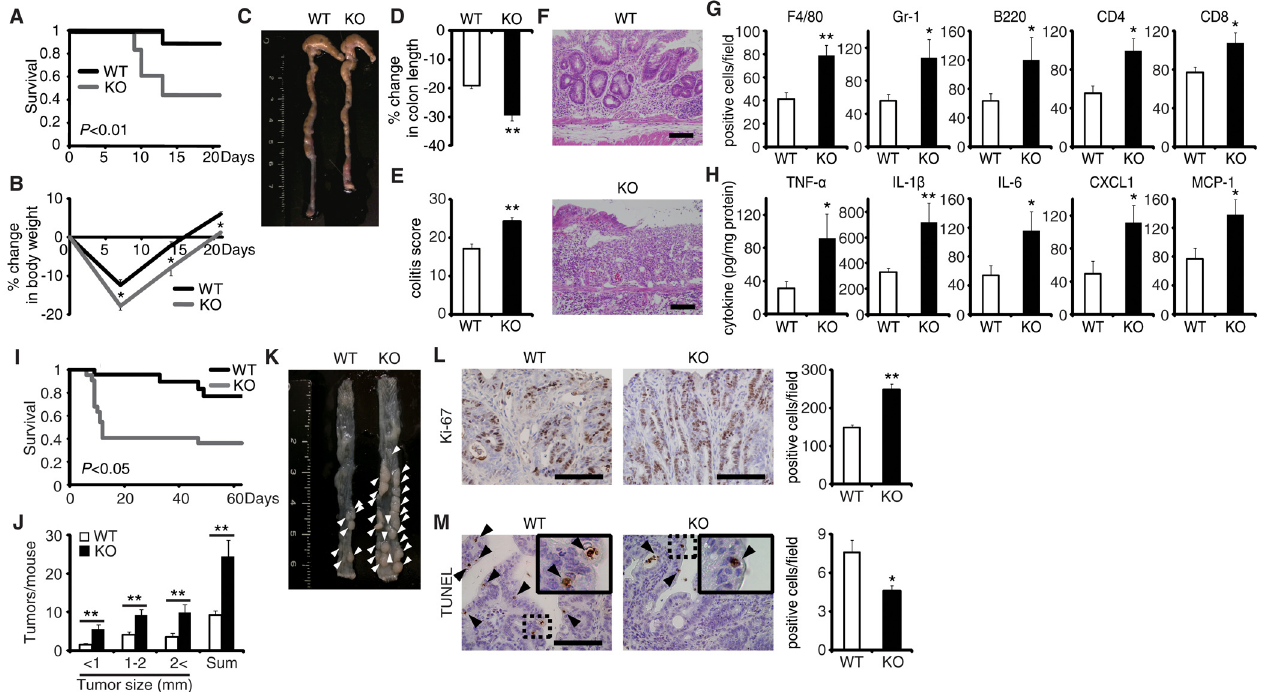
Fig 1. EPRAP deficiency exacerbates DSS-induced colitis and adenoma formation after AOM/DSS treatment. (A) Survival curves during the DSS treatment. Elevated mortality was observed in EPRAP-deficient (KO) mice, relative to WT (n = 18 each, * P < 0.01). (B) Percent changes in body weight (n = 16 [WT]; n = 17 [KO]). (C) Representative photographs of colons from each group. (D) Percent changes in colon length in WT and KO mice (n = 8 [WT]; n = 5 [KO]) in comparison to those of mice received DSS-free water. (E) Histological colitis scores (n = 10 each). (F) Representative H&E staining of rectal sections. (G) The numbers of F4/80-, Gr-1 – , B220-, CD4-, and CD8-positive cells infiltrated in colonic tissues per high-power field (400× magnification) (n = 8 each). (H) The expression levels of TNF- α , IL-1 β , IL-6, CXCL1, and MCP-1 protein in colonic tissue extracts from DSS-treated WT and KO mice (n = 15 [WT]; n = 9 [KO]). (I) Survival curves during the AOM/DSS treatment (n = 18 [WT]; n = 22 [KO], P < 0.05). (J) The number of colonic tumors per mouse, with size distribution (left) and total number (right) in AOM/DSS-treated WT and KO mice (n = 9 [WT]; 8 [KO]). (K) Representative photographs of colons at the end of AOM/DSS treatment. (L) Ki-67 – positive cells in rectal polyps of AOM/DSS-treated WT and KO mice (left). KO mice exhibited greater numbers of Ki-67 – positive cells than WT mice (right) (n = 5 each). (M) TUNEL assays on polyps of AOM/DSS-treated WT and KO mice. The arrows point to TUNEL-positive apoptotic cells: the insets show higher magnifications of selected regions (indicated by dashed boxes) (left). KO mice exhibited fewer TUNEL-positive cells than WT mice (right) (n = 5 each). All values represent means ± SEM. * P < 0.05, ** P < 0.01 vs. WT mice. Scale bars: 100 μ m.